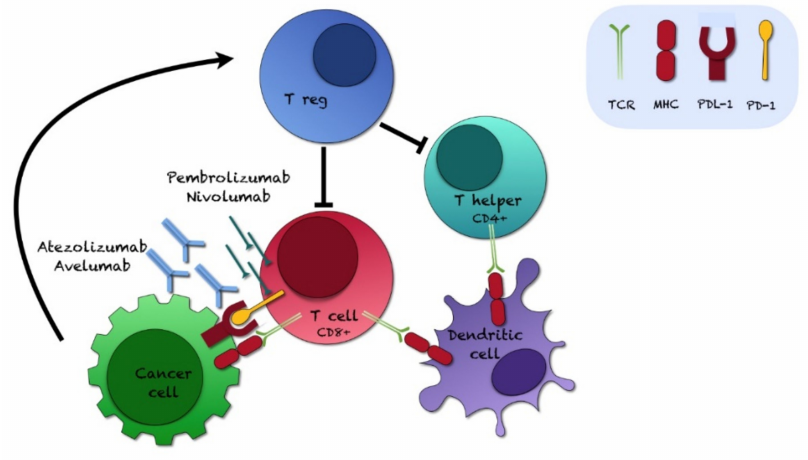
Figure 2. Inhibitors of PD-1 (Pembrolizumab, Nivolumab) and PD-L1 (Atezolizumab, Avelumab).